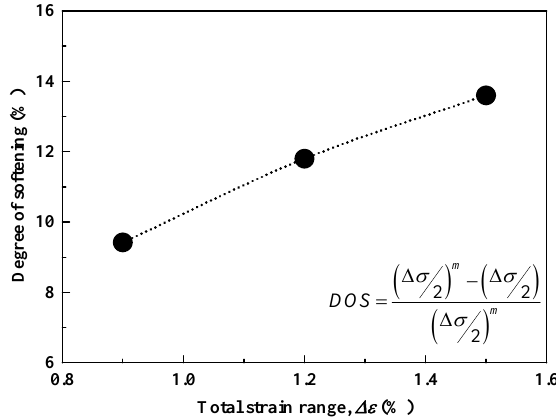
Figure 8. Degree of softening as a function of the total strain range of Alloy 617 at 950 °C.